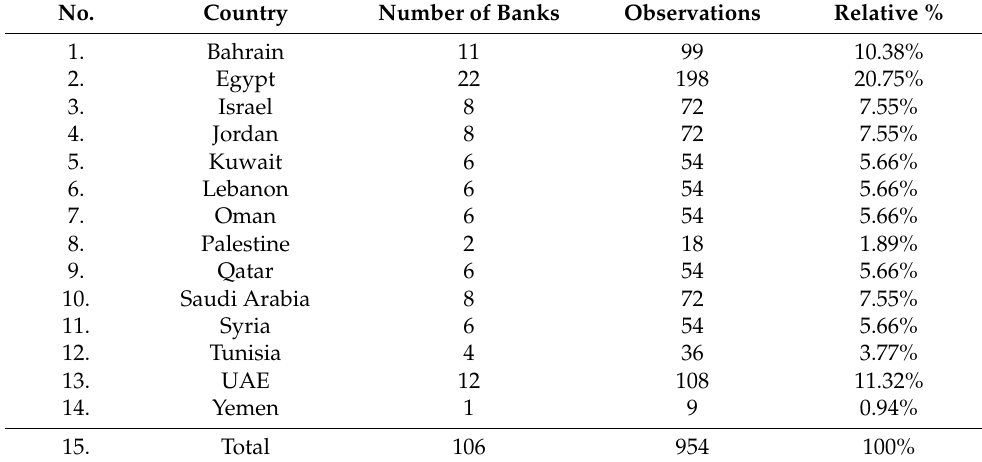
Table 1. Sample distribution by